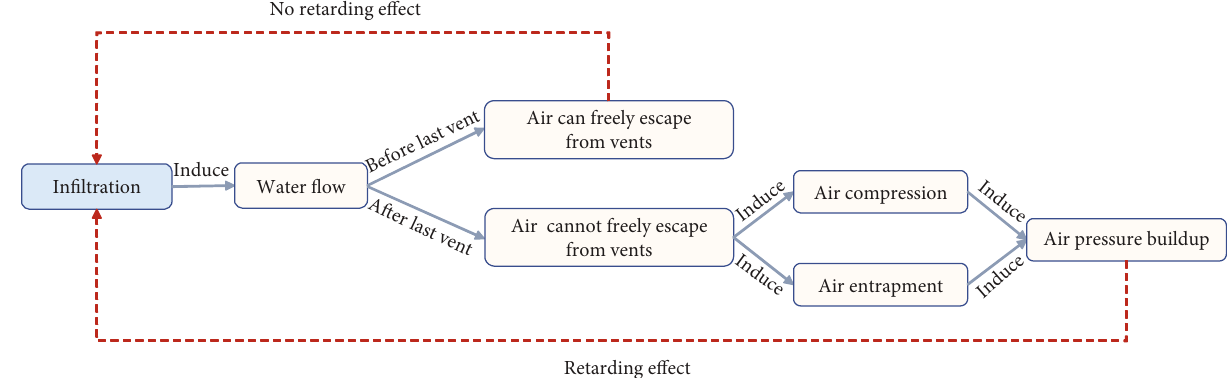
Figure 9: A conceptual fi gure illustrating the mechanism responsible for the role of air fl